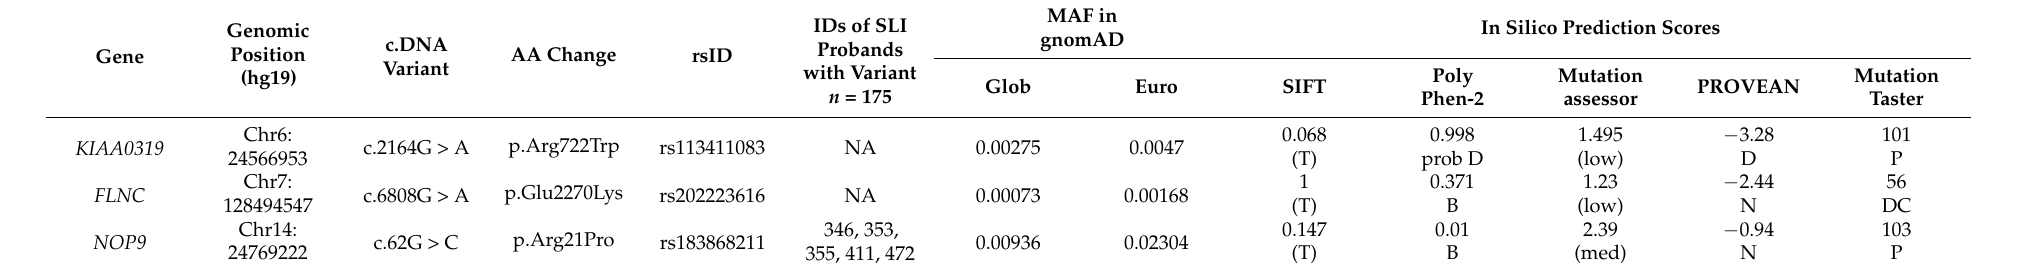
Table 1. WES variants identified in candidate genes previously suggested for language and related phenotypes in family 489.